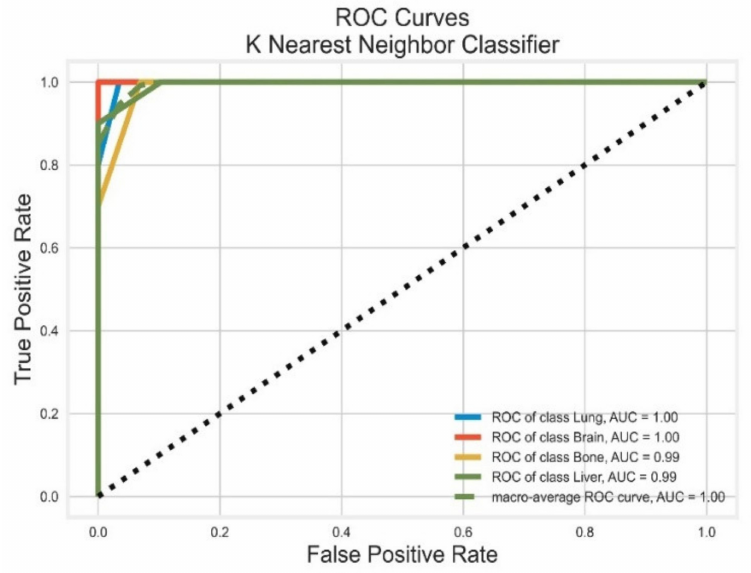
Figure 24. ROC Curves (K-Nearest Neighbor